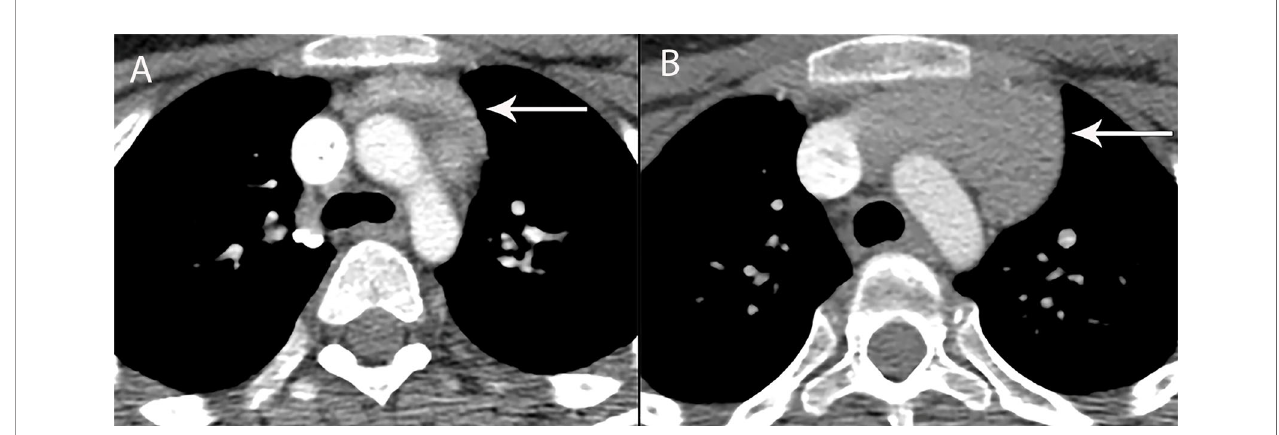
FIGURE 6 | 13 year old boy with chondroblastic osteosarcoma of the femur, treated with methotrexate, doxorubicin, cisplatin (A) CT shows the normal thymus (arrow) at baseline. (B) CT 4 months later shows increase in size of the thymus consistent with rebound hyperplasia (arrow). Enlargement of the thymus gland due to hyperplasia during the recovery phase from physical stress such as after chemotherapy or recovering from burns, does not displace or change the contour of vessels surrounding it. In the appropriate clinical context of thymic hyperplasia, CT is adequate for diagnosis and MRI is not needed for con fi rmation.